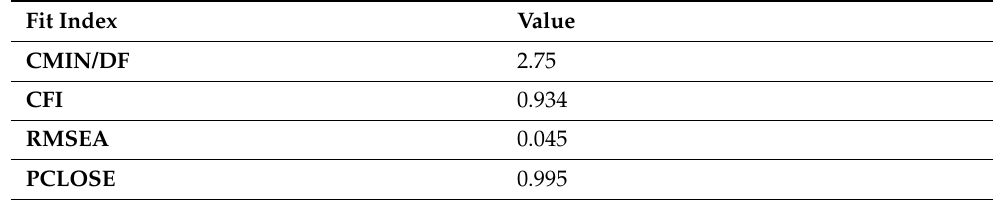
Table 5. Descriptive Statistics and Reliability.